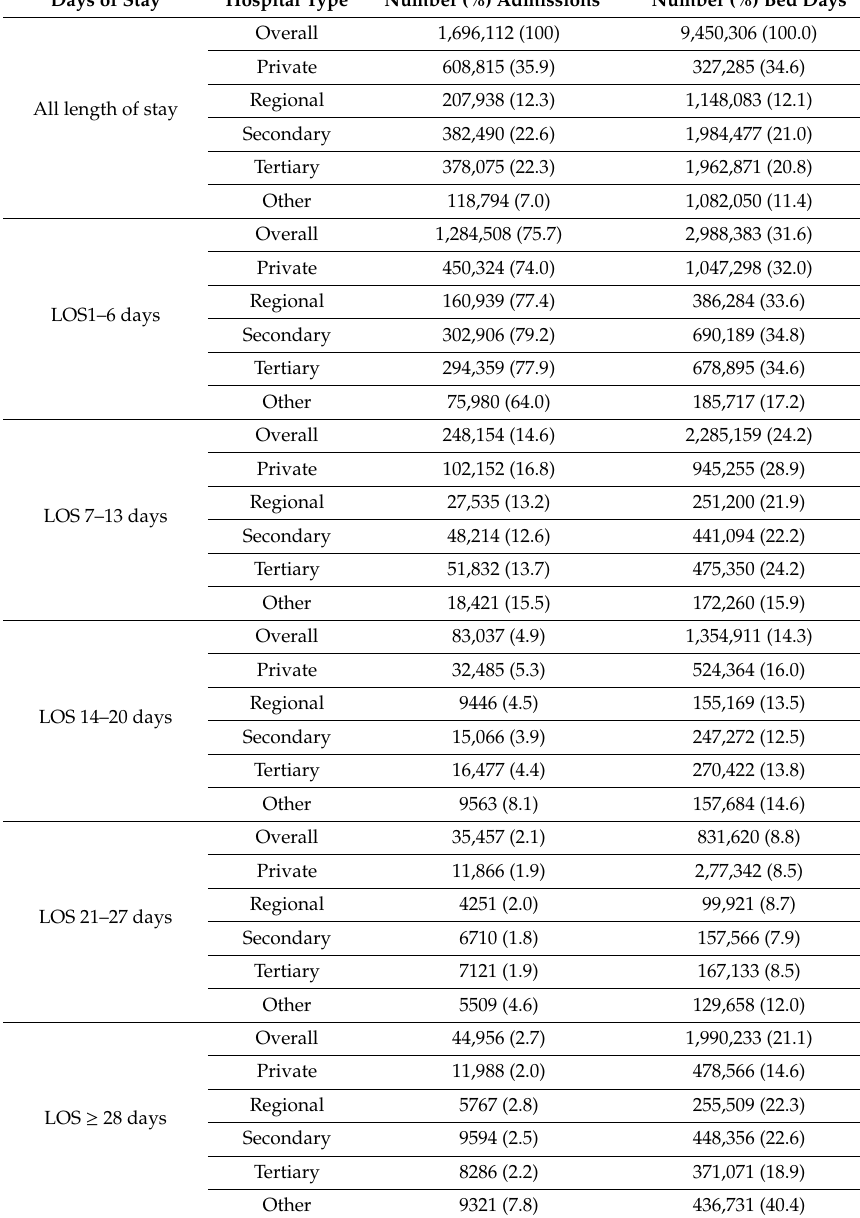
Table 2. Details of bed utilization according to hospital length of stay and hospital type for patients hospitalized over two years in Victoria,